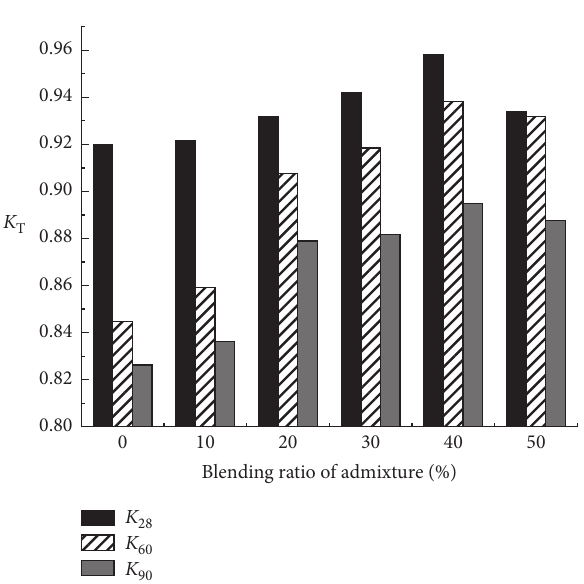
Figure 5: Change of coefficient K